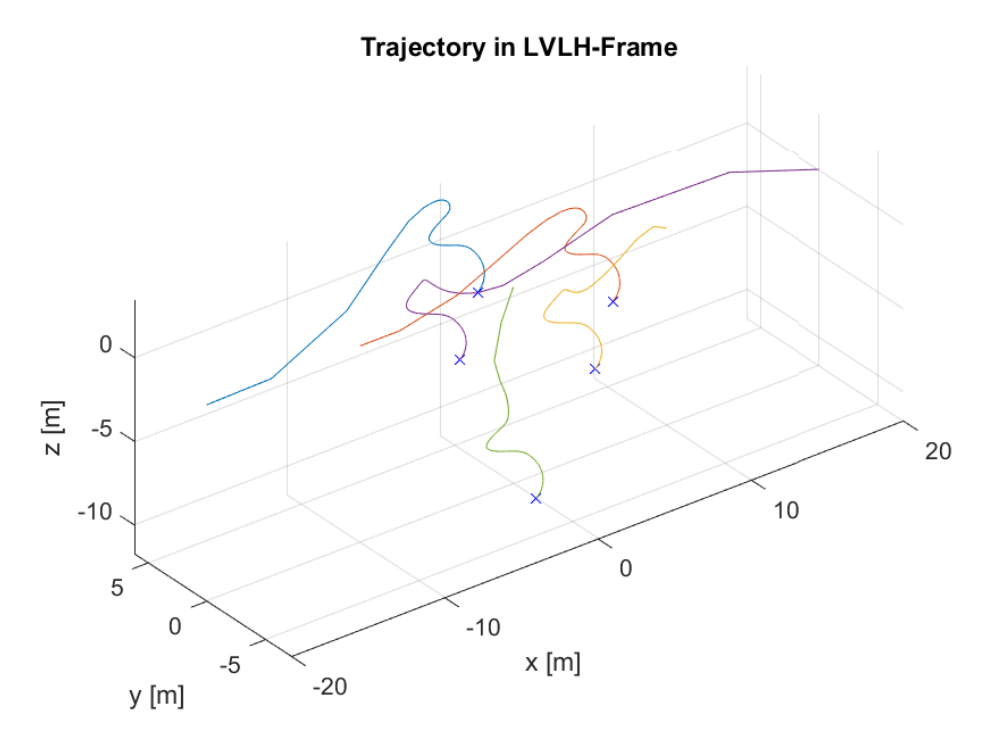
Figure 12. 3D plot of the trajectories of the five satellites subject to the presented consensus-based controller starting on v-bar ( − 20, − 10,0,10,20 m).